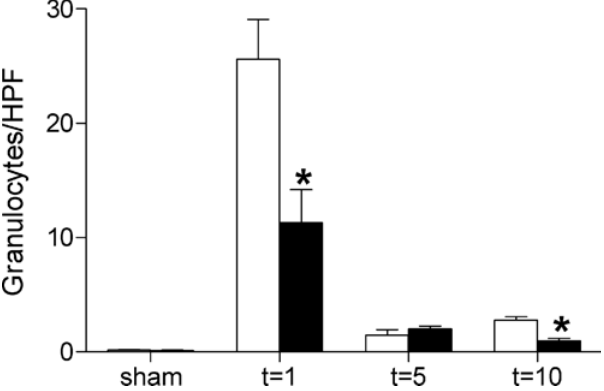
Figure 5. Invitro production of proinflammatory cytokines and chemokines by wild type and TLR4 2 / 2 TECs. Production of proinflammatory cytokines and chemokines by primary murine TECs from TLR4 2 / 2 (black) and wild type (white) mice, subjected to simulated ischemia. TLR4 2 / 2 TECs produce significantly lower amounts of KC as compared with TECs from wild type mice when subjected to simulated ischemia, whereas levels of MCP-1 were similar. Data are mean 6 SEM of 4–5 mice per group, measured in duplicate. * p , 0.05. Ctr, control; Isch, Ischemia.